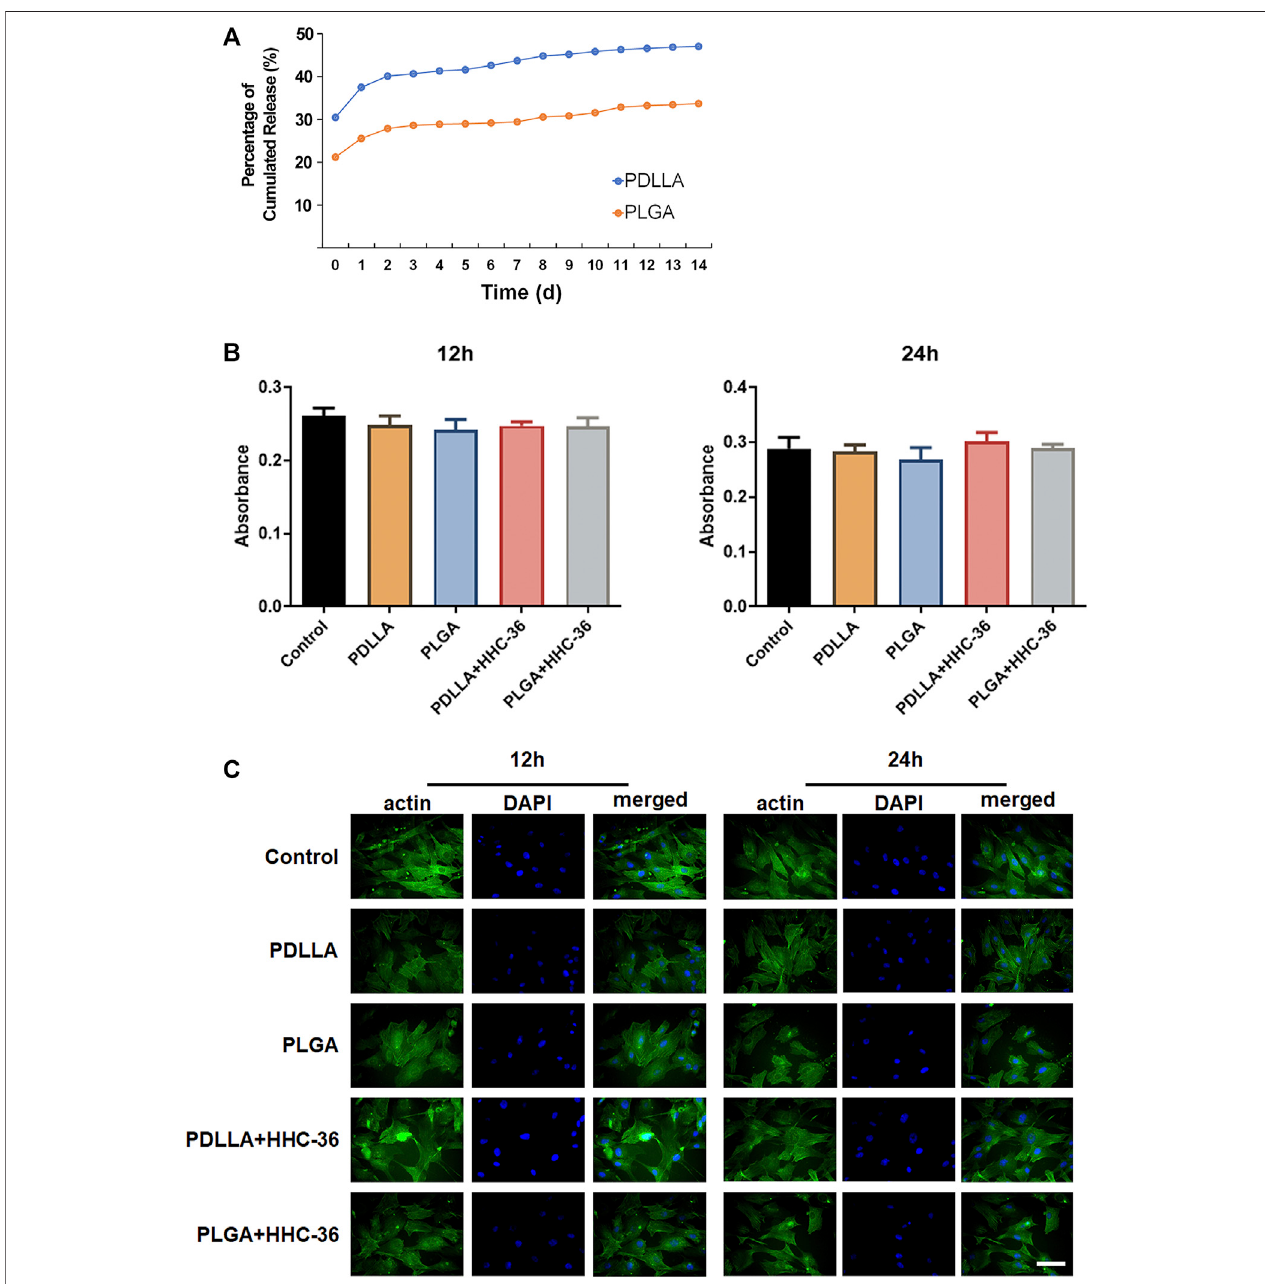
FIGURE2| BiocompatibilityofthePDLLA/PLGA-HHC-36coatedtitaniumnanotube.( A )Kineticsof invitro releaseofHHC-36withPDLLA/PLGAcoatings.( B )Cell cytotoxicityexaminationusingtheCCK-8test.Adultdermal fi broblastscellsintervenedbyeluentsofeachgroupwereevaluatedat12and24 h.( C )Immuno fl uorescence results of actin expression at 12 and 24